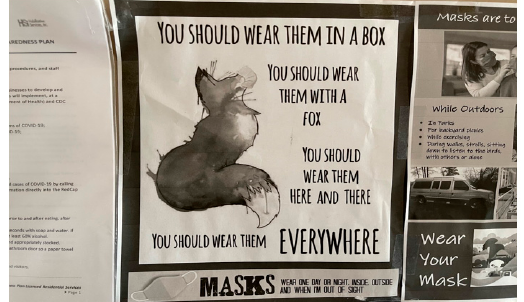
Figure 5. This funny poster was used to remind others to wear their